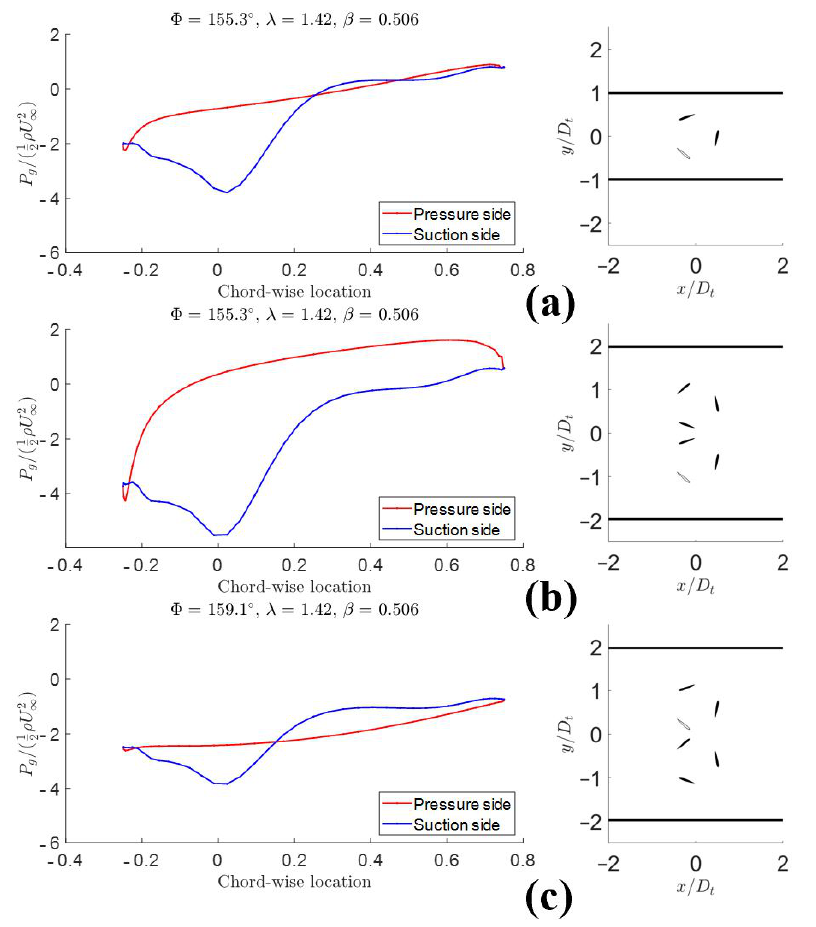
Figure 24. The pressure loading on one of the turbine blades after reaching its maximum torque angle of the 3 configurations: Single turbine ( a ), forward counter-rotating turbines ( b ), and backward counter-rotating turbines ( c ). The relevant blade is colored in white on the right